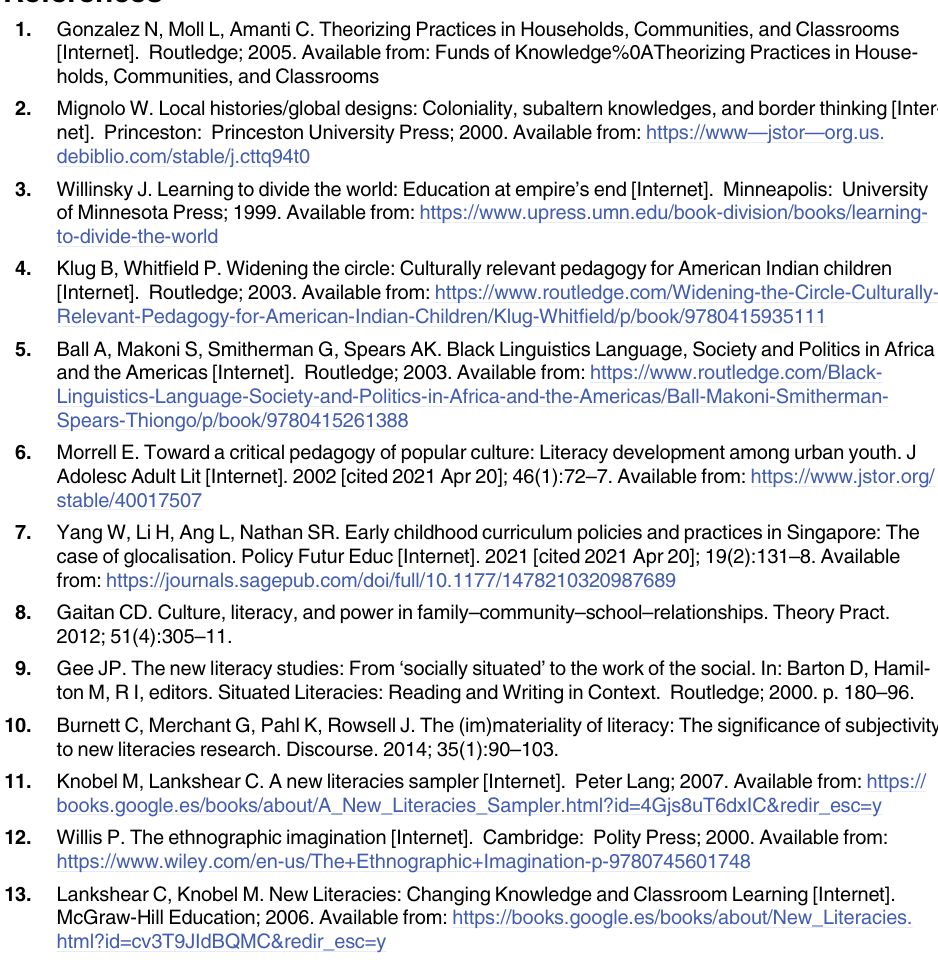
S3 Table. The teacher’s and students’ communicative shifts between modes in the radio program